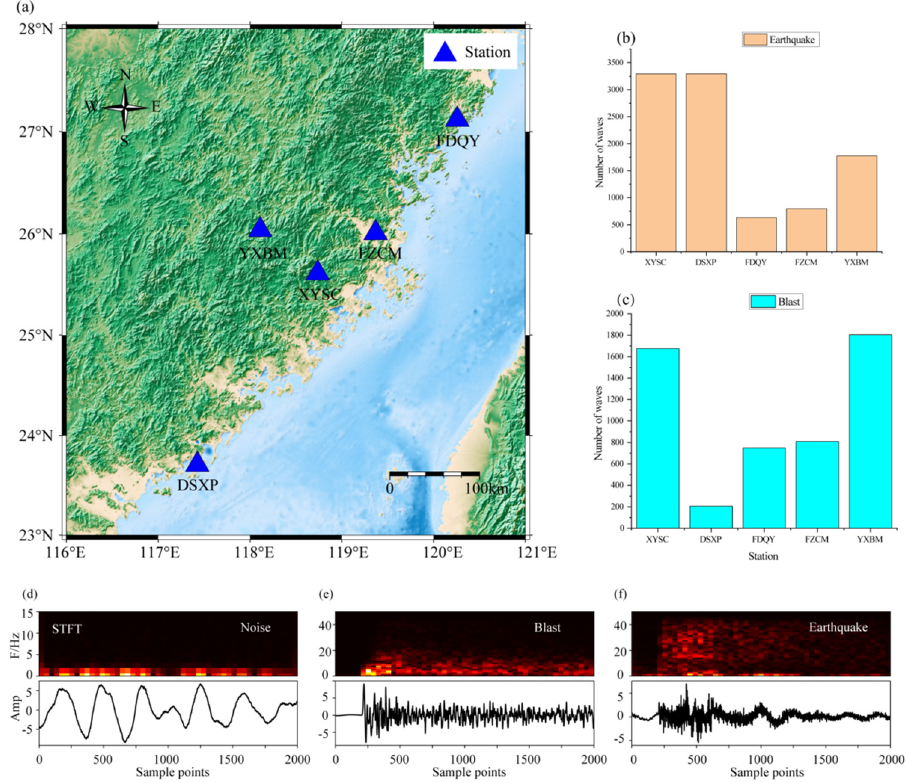
Figure 1. Overview of the study data. ( a – c ) Station distribution and the waves number in the 5 sta- tions. ( d – f ) Noise, blast, and earthquake signal sample. 5 stations. ( d – f ) Noise, blast, and earthquake signal sample. Table 1. Number of waveforms recorded at each